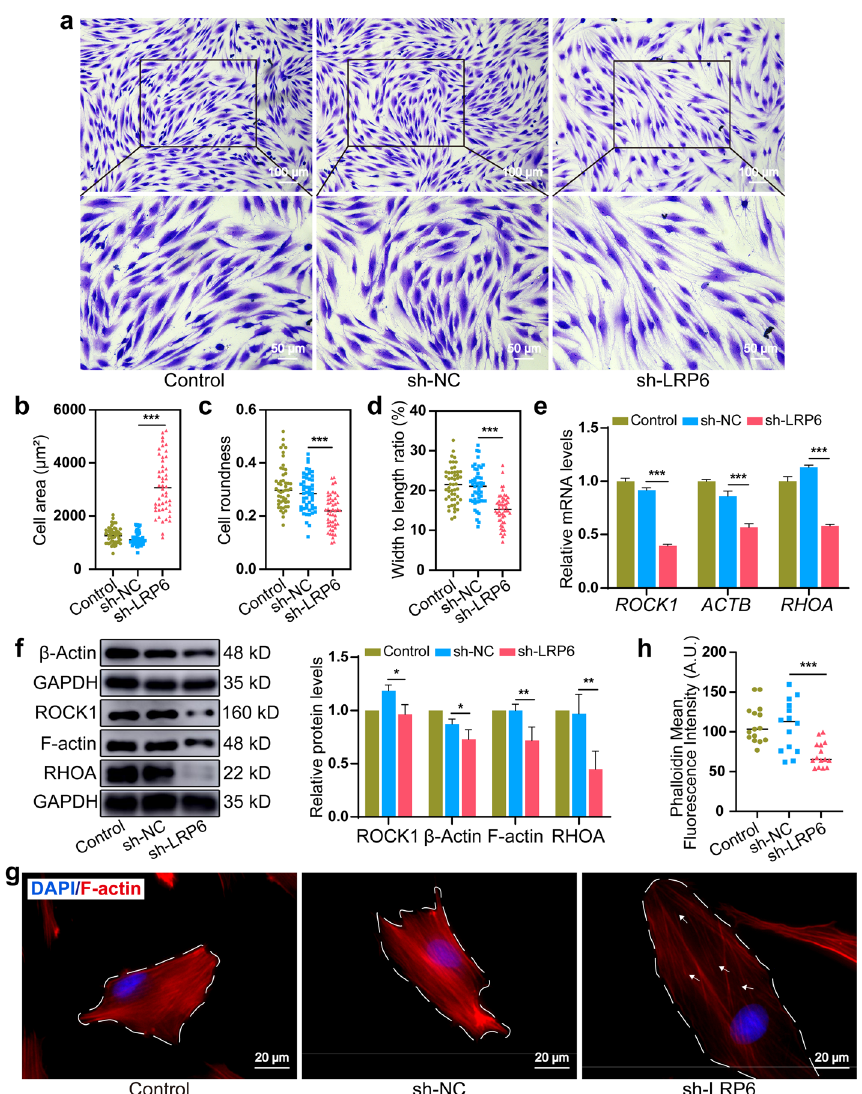
Fig. 3 LRP6 inactivation disrupted F-actin dynamics in force-induced PDLSCs. a Imaging cell shape after stretching for 24 h by optical microscopy. Scale bars, 100 μm and 50 μm. b Quantification of cell area, c roundness, and d width-to-length ratio for the control, sh-NC, and sh-LRP6 group after stretching for 24 h. e The mRNA levels of ROCK1 , ACTB , and RHOA in the control, sh-NC, and sh-LRP6 group after stretching for 24 h. f The protein levels of β-Actin, F-actin, ROCK1, and RHOA in the control, sh-NC, and sh-LRP6 group after stretching for 24 h. g , h Phalloidin fluorescence staining and semi-quantitative analysis in the control, sh-NC, and sh-LRP6 group after stretching for 24 h. Scale bar, 20 μm. * P < 0.05, ** P < 0.01, *** P < 0.001. Results are presented as mean SD of triplicated ±